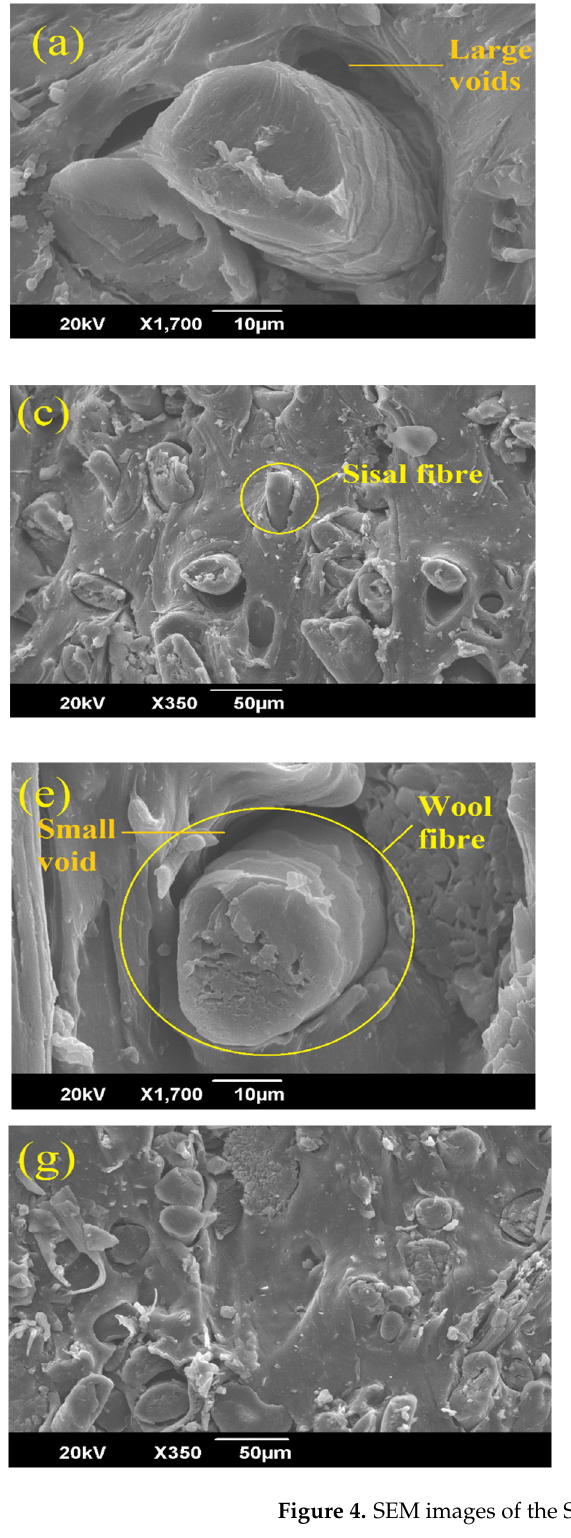
Figure 4. SEM images of the SWHC ( a – d )and the PWHC ( e – h )at various